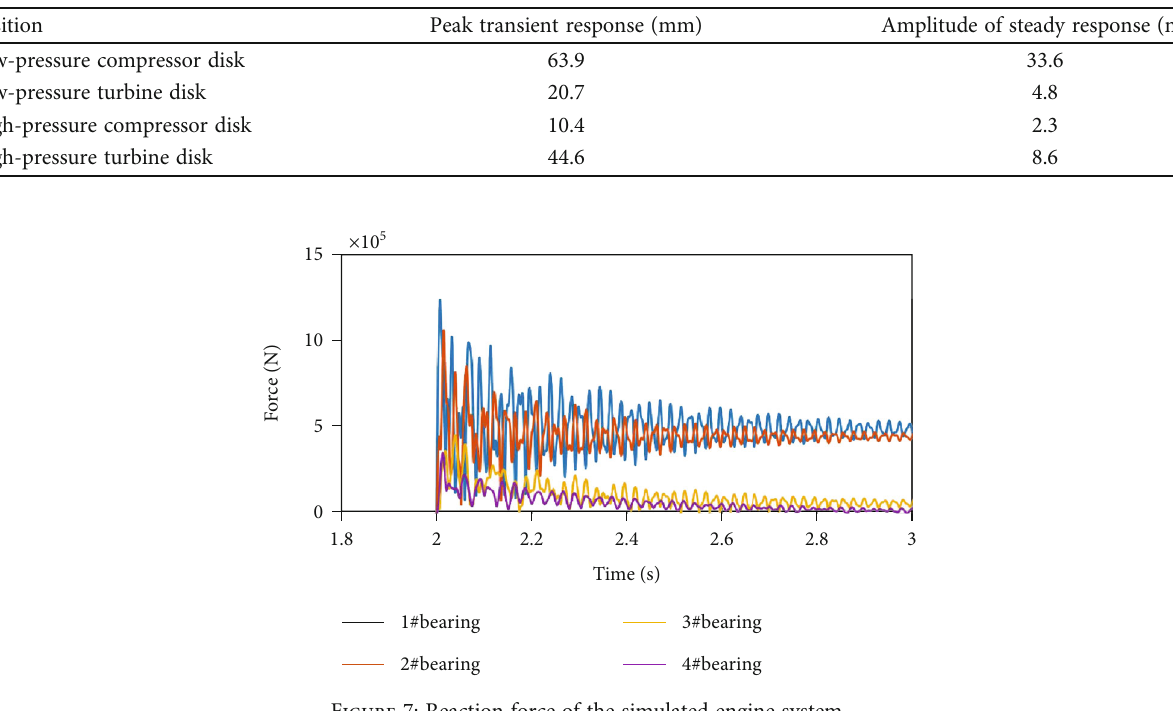
Figure 6: Vibration response of the simulated engine Table 4: Displacement response of the simulated engine system.